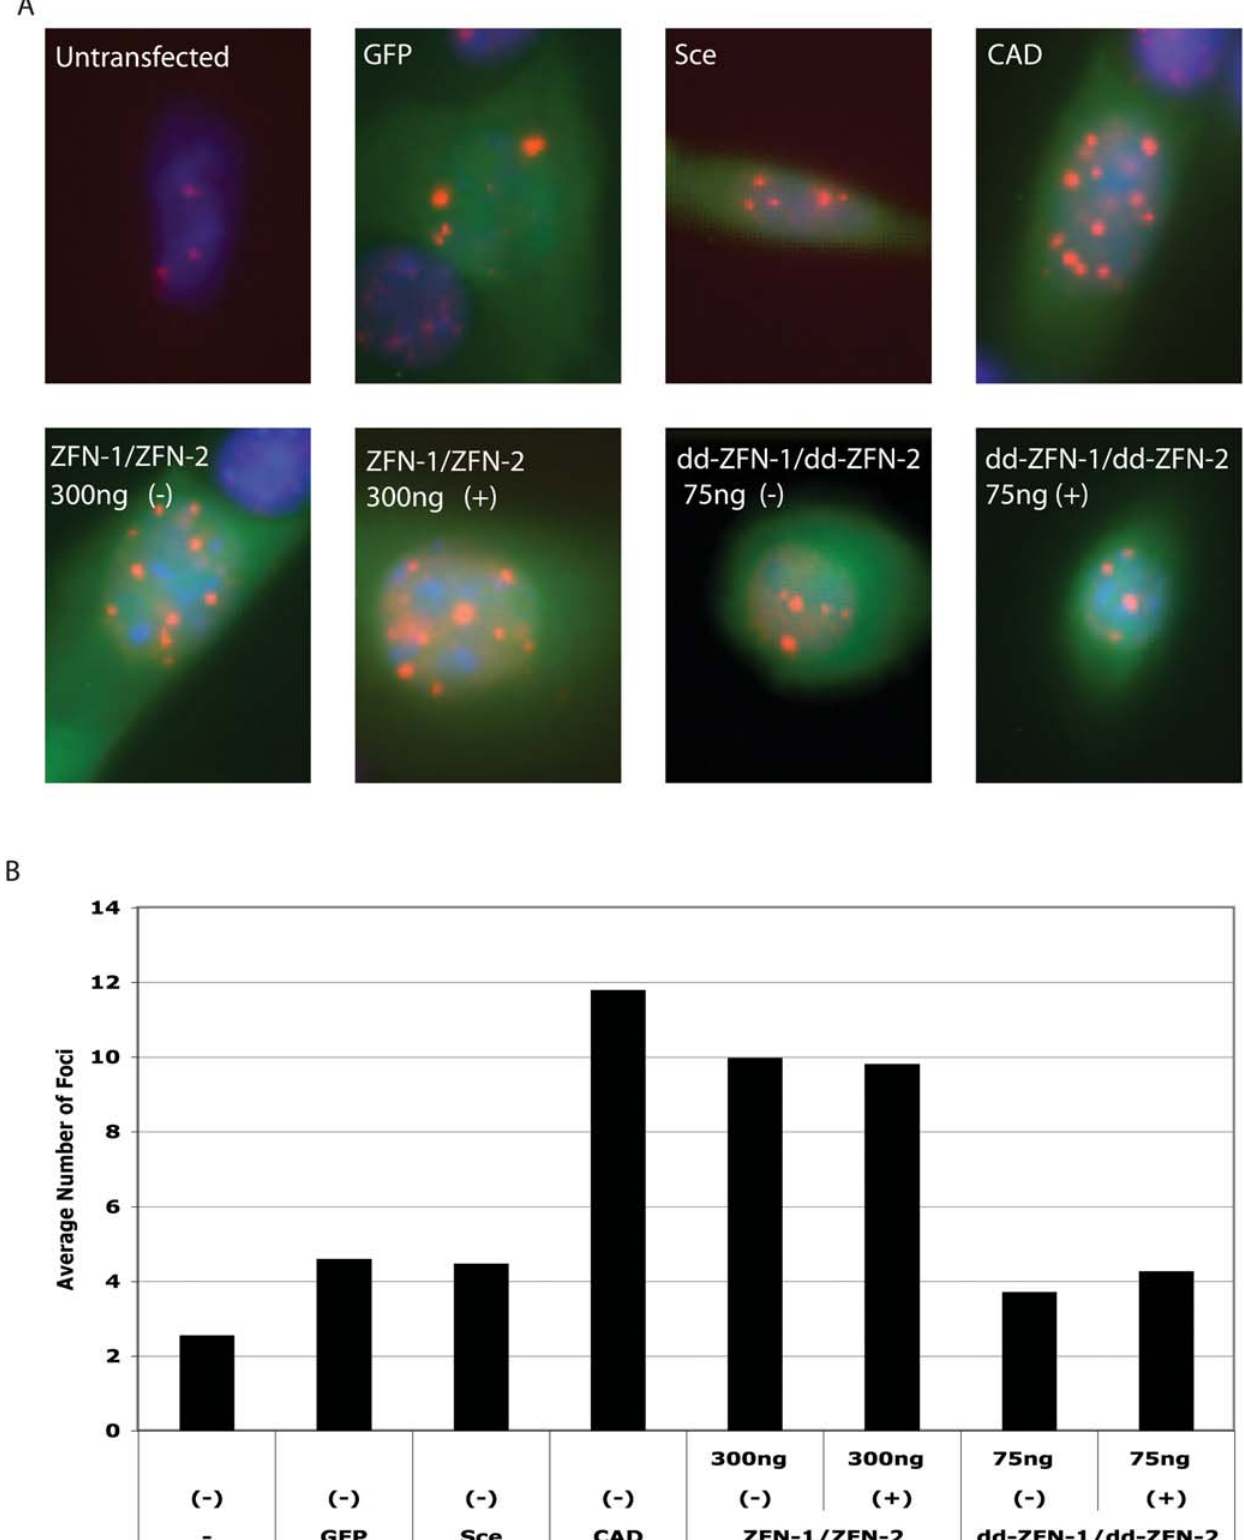
Figure 5. Visualization of ZFN-induced DSBs by sensitized 53BP1 foci formation assay. (A) Representative cells for each experimental condition after 53BP1 staining using indicated amounts of transfected DNA of each nuclease in the presence or absence of drug. 53BP1 foci are seen in red, 4,6-diamidino-2-phenylindole staining in blue, and GFP-positive cells in green. The foci were counted in transfected cells that were GFP- positive. ‘‘Untransfected’’ shows the background staining for foci in these cells, GFP indicates transfection of GFP alone, Sce serves as a negative